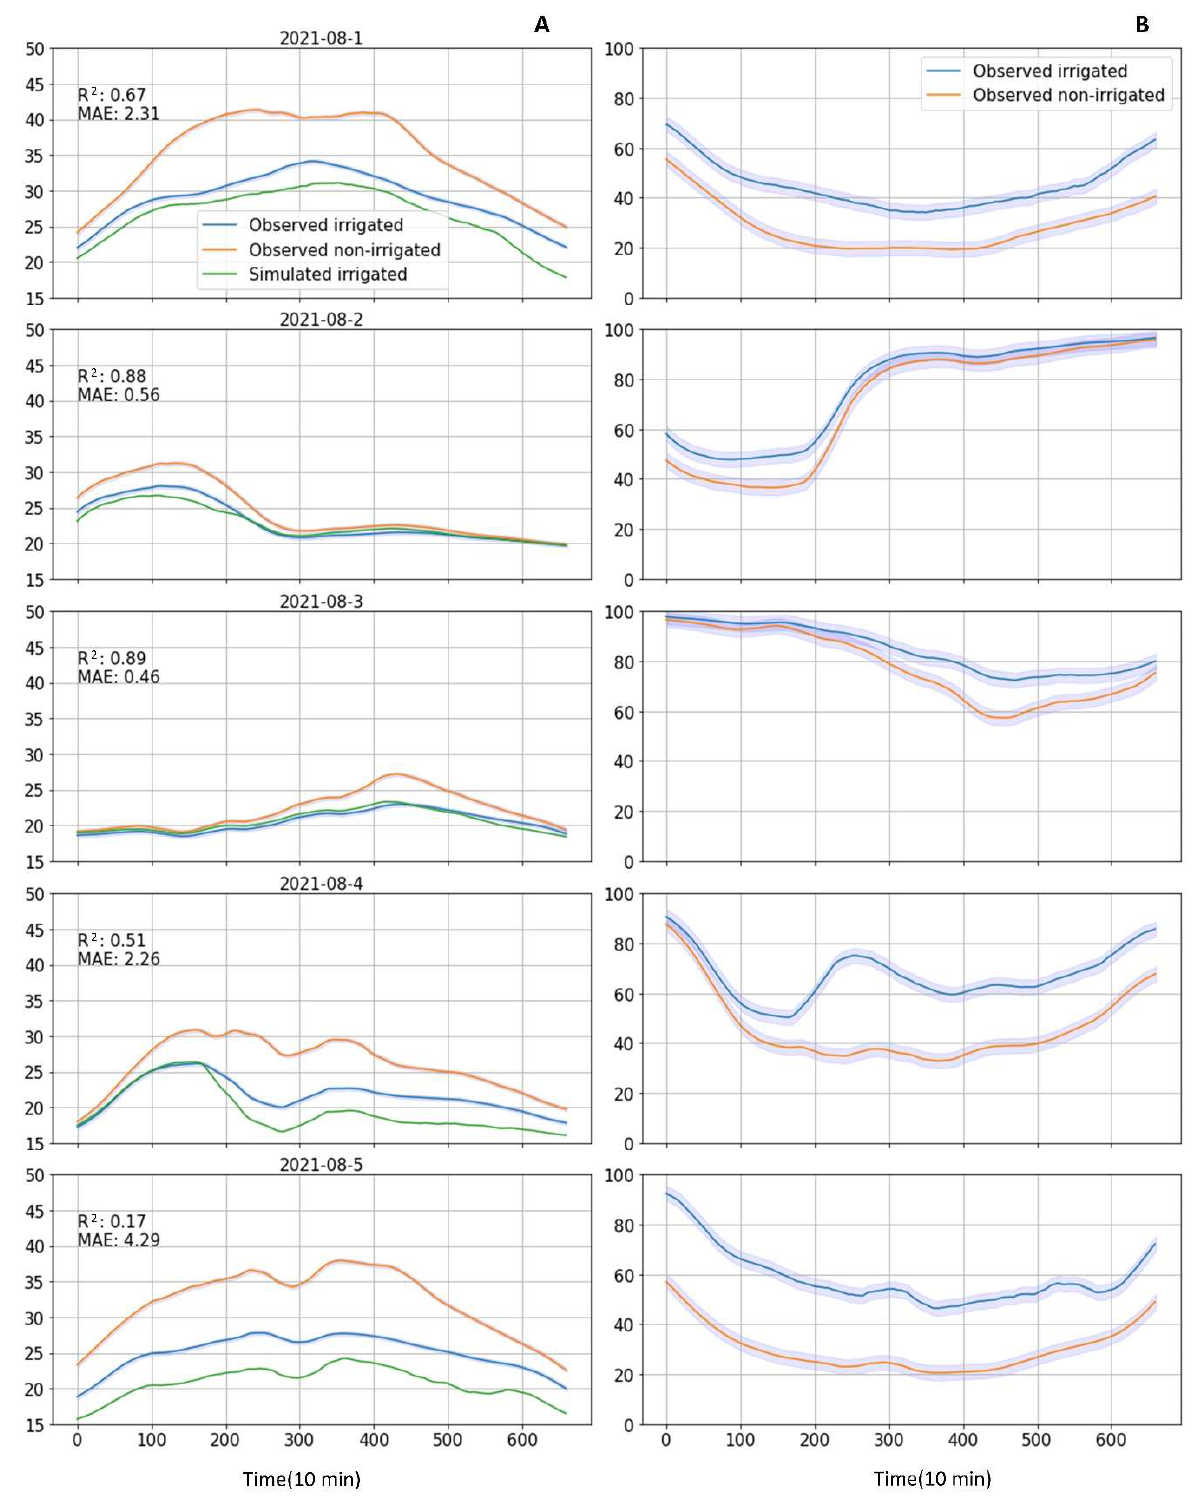
Figure 5. The air temperature (°C) ( A ) and relative air humidity (%) ( B ) at a ten-minute resolution between 10:00 and 21:00 below the canopy for the days between the first and the second irrigation event.